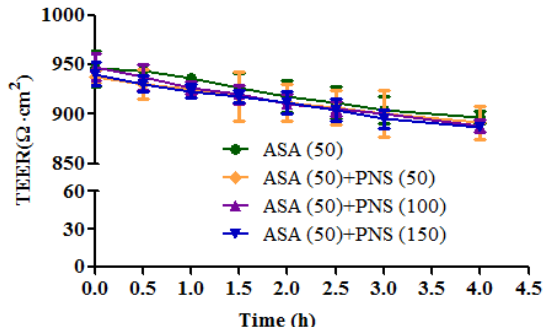
Figure 6. Transepithelial electrical resistance of Caco-2 cell monolayers monitored in the whole transport process from apical to basolateral direction. Resistance was measured using a Millcell-ERS resistance system and calculated from the background-corrected resistance. The TEER at each time point was presented as mean ± SD ( n = 3).